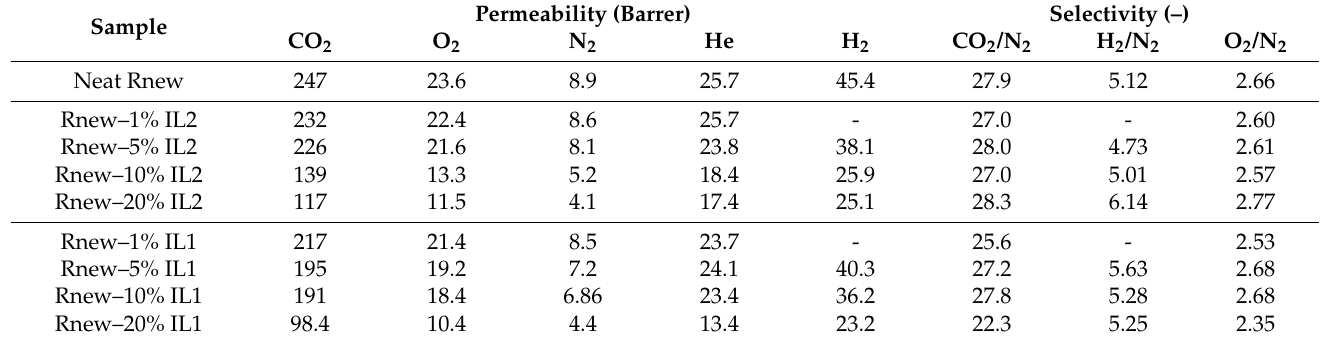
Table 2. Gas permeability measured on the as-prepared Pebax ® Rnew and Pebax ® Rnew/IL composite membranes at 25 ◦ C.